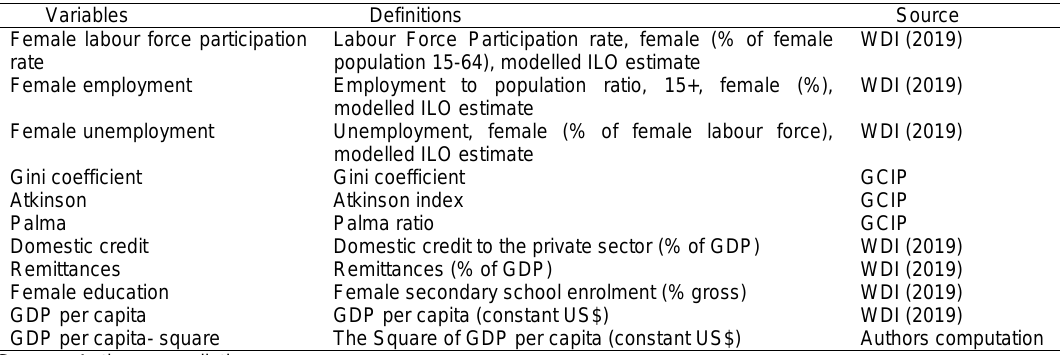
Table 1. List of Variables and